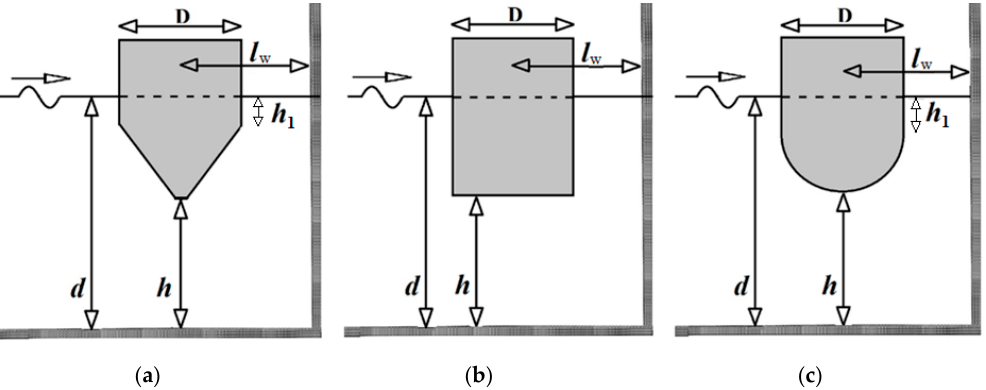
Figure 1. 2-D representations of the examined types of floaters in front of a breakwater: ( a ) a conical floater; ( b ) a vertical cylindrical floater; ( c ) a semi-spherical floater.